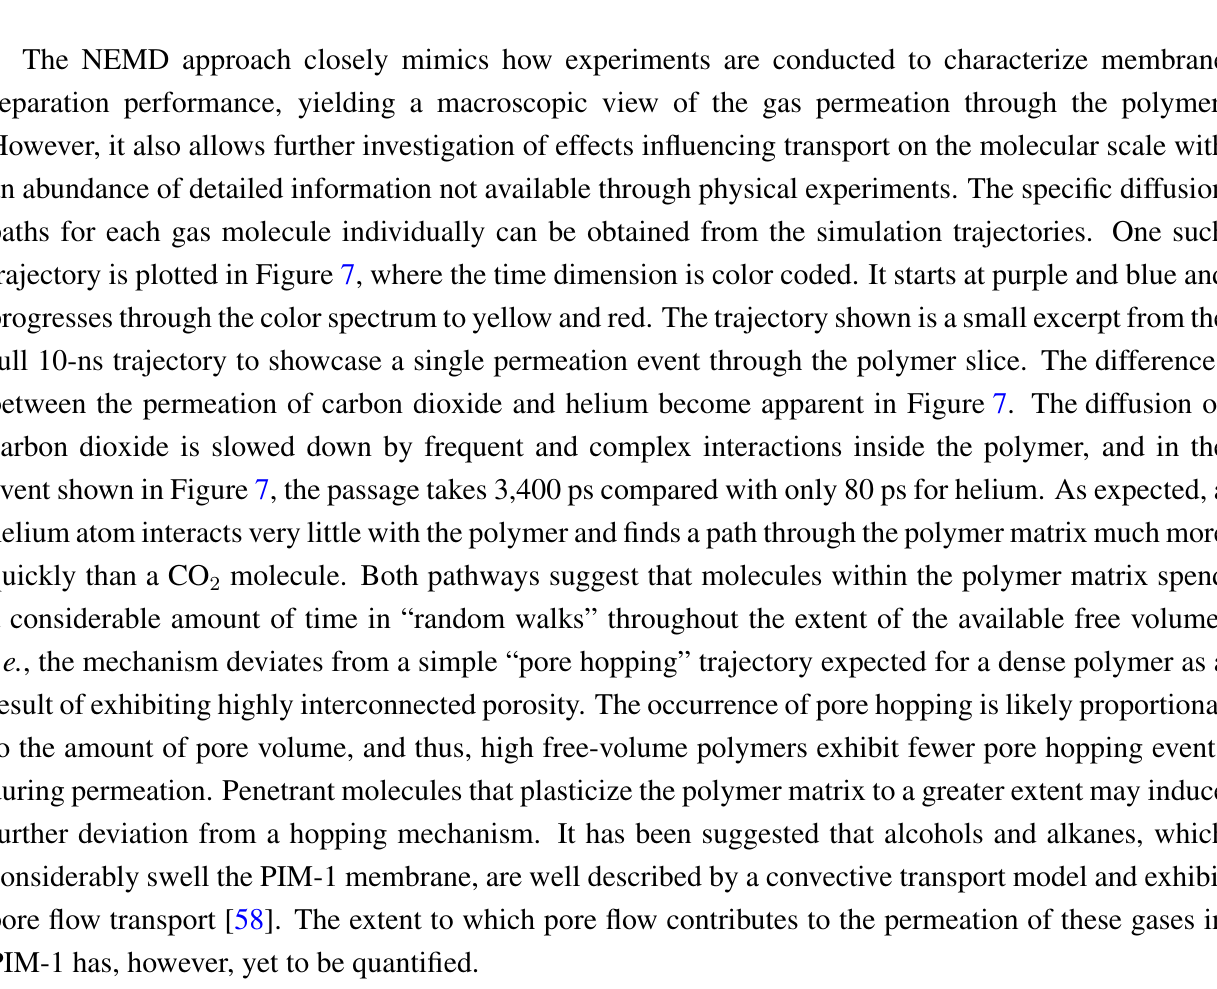
Figure 6. Permeability and solubility results from NEMD simulations compared to experimental results for helium in blue and carbon dioxide in red [51,53,54,56,57]. The shaded area of the bar chart shows the spread of experimental data and the estimated error for simulations results in the case of permeability. Solubilities are obtained from a single initial equilibration, and since their calculation is very robust, errors for solubility were not